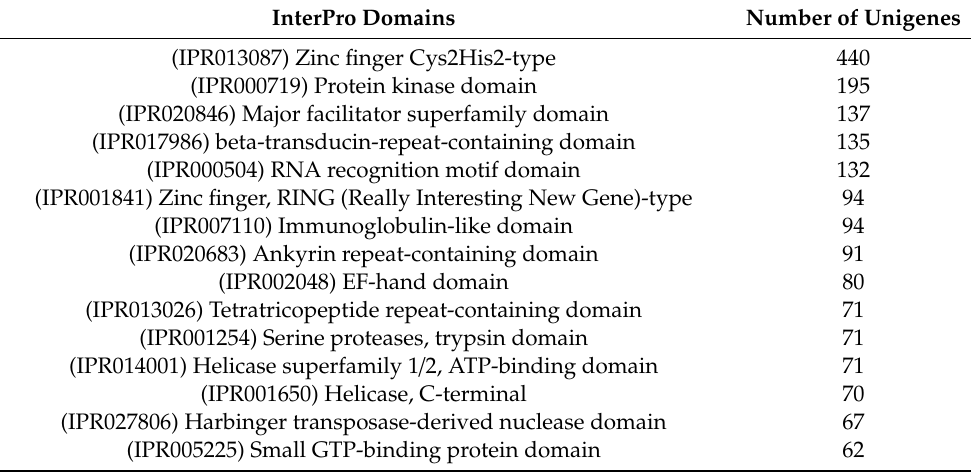
Table 2. Top 30 InterPro domains distribution of the unigenes assembled.